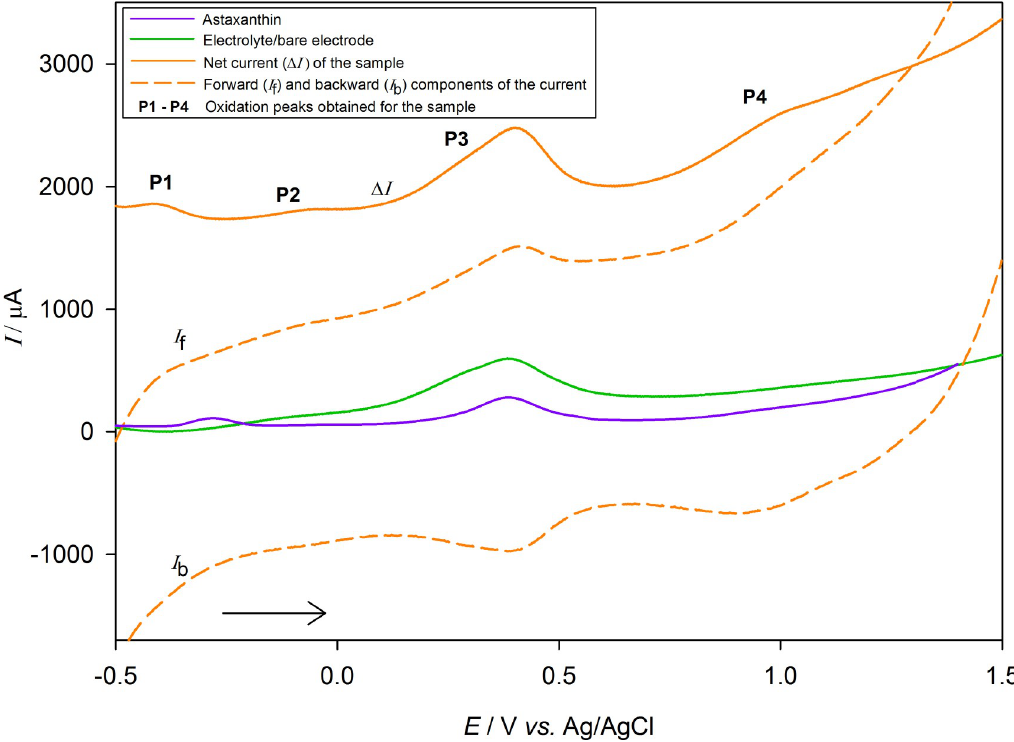
Fig 6. Square-wave voltammogram. The voltammogram corresponds to the oxidation of precipitate film of extract from digestive gland of Mediterranean scallops in winter, immobilized on PIGE and immersed in 0.1 M HClO 4 solution. SWV of bare electrode (- � -) in the same electrolyte is also shown. The frequency was 100 Hz, pulse amplitude was 50 mV and step potential was 2 mV. Peaks P1, P2 and P4 are typical for carotenoids.